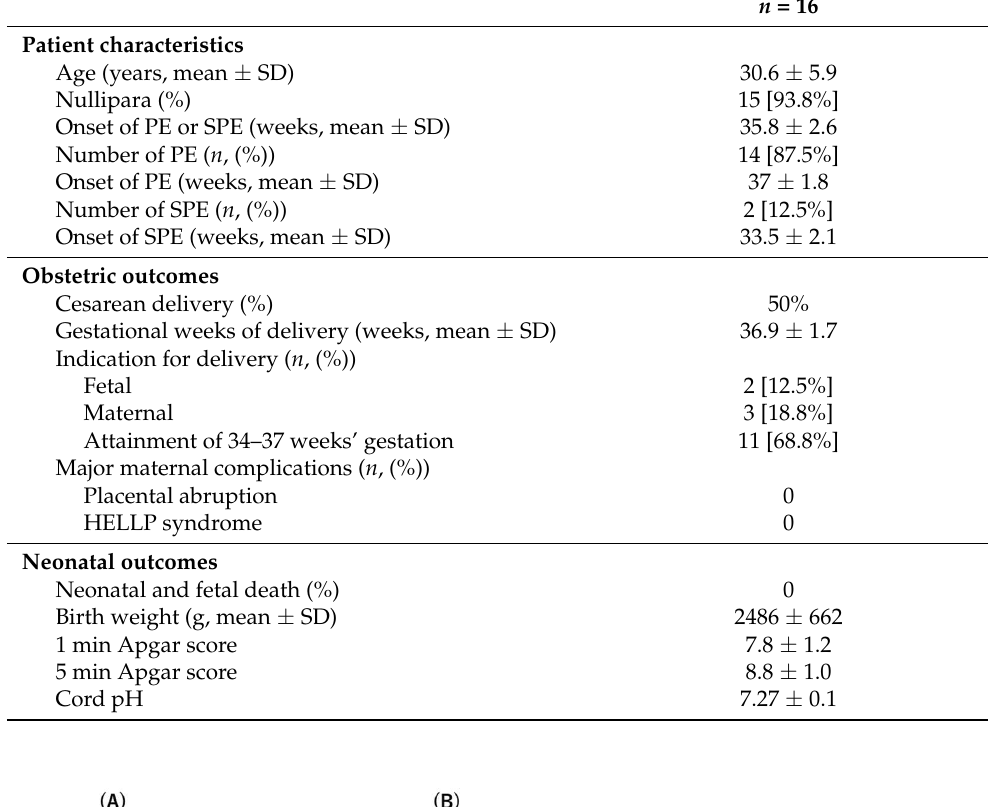
Table 1. Patient characteristics and obstetric and perinatal outcomes in the MgSO 4 nontreatment group. PE: preeclampsia; SPE: superimposed preeclampsia.